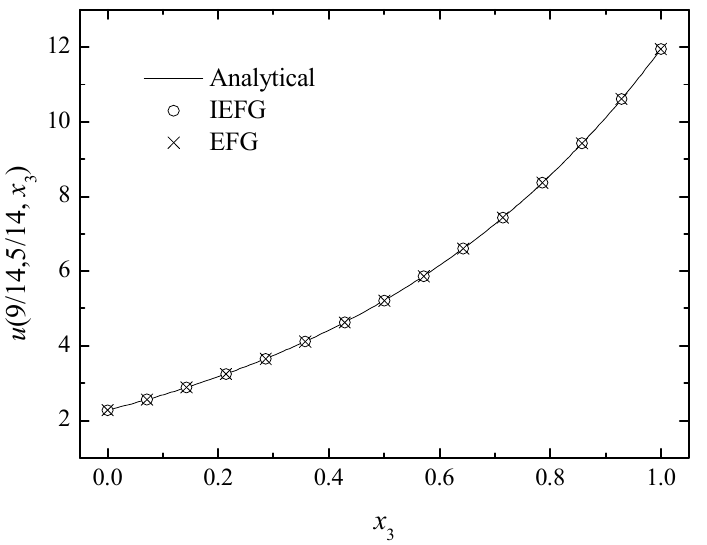
Figure 9. The comparison of the numerical and analytical solutions of the two methods along the x 3 -axis.